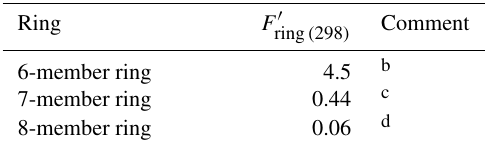
Table 5. Optimized ring factors at 298K, F (cid:48) tions of O 3 with cyclic conjugated dialkenes a